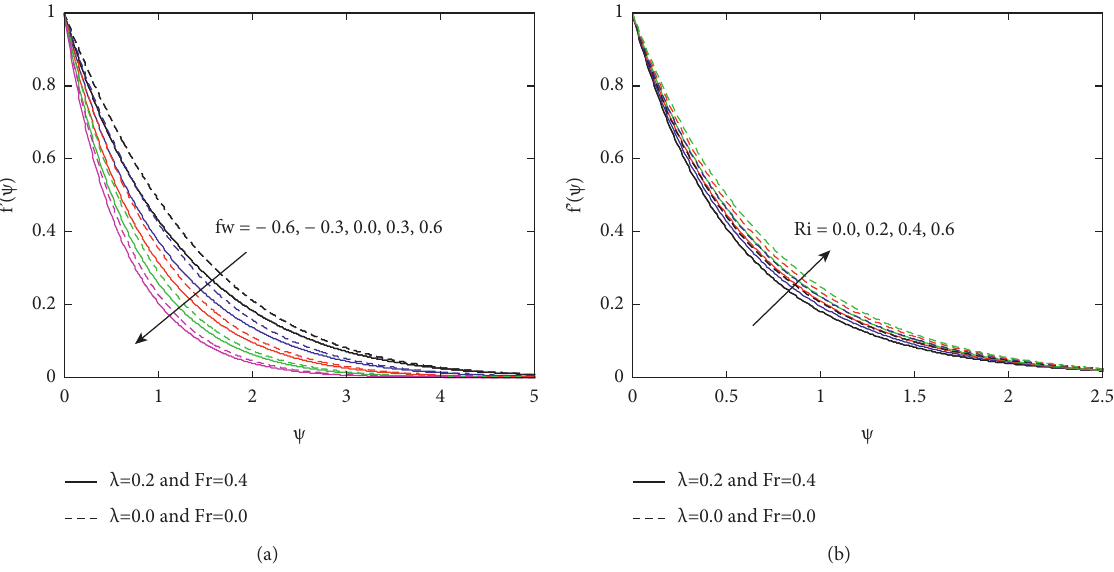
Figure 3: The velocity distribution for diverse quantity of fw (a) and Ri (b).